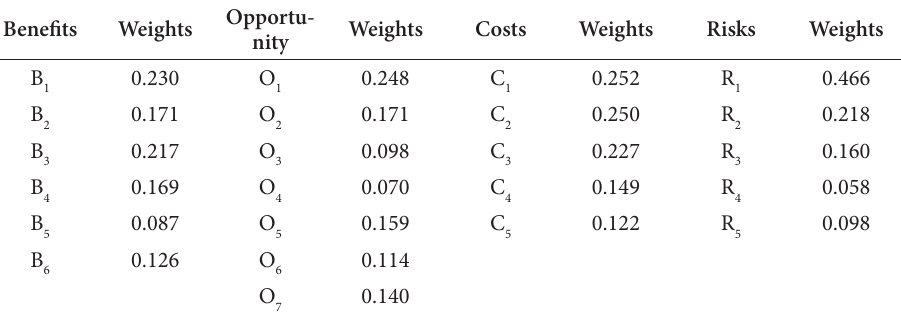
Table A7. The importance weights of sub-criteria with BOCR by FAHP Opportu- Weights Costs Weights Risks Benefits Weights nity